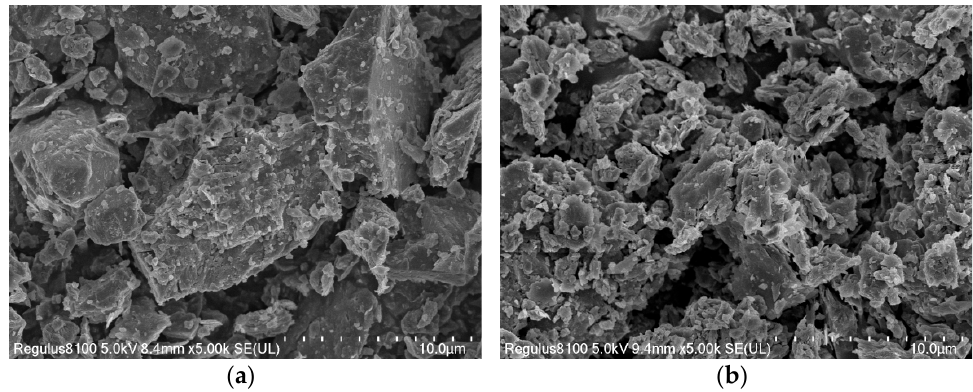
Figure 11. Magnify 5000 times the microscopic morphology photos: ( a ) Limestone powder; ( b ) Coal gangue powder. Table 3. The relative content of the main chemical components of limestone powder and coal gangue powder.